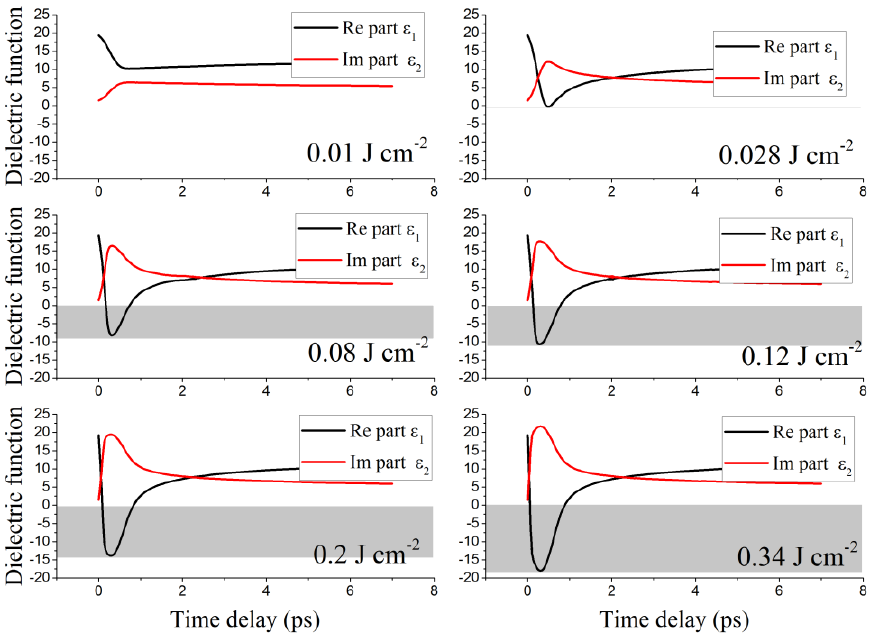
Figure 5. Temporal evolution of the dielectric function of the Ge thin film under a single 300 fs-laser pulse irradiation, at 1030 nm wavelength and at different laser fluences ranging from 0.01 J cm − 2 to 0.34 J cm − 2 . Grey bands indicate a negative value of the real part ε 1 of the dielectric function.